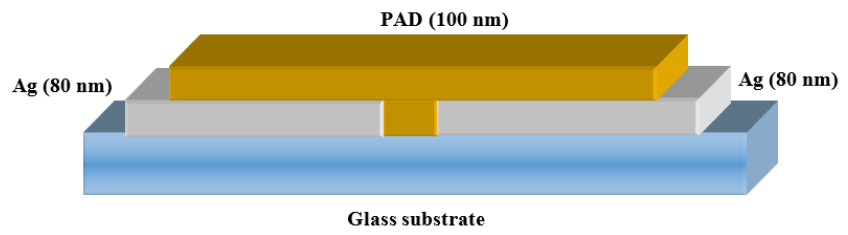
Figure 1. Schematic structure of Ag/PAD/Ag device.